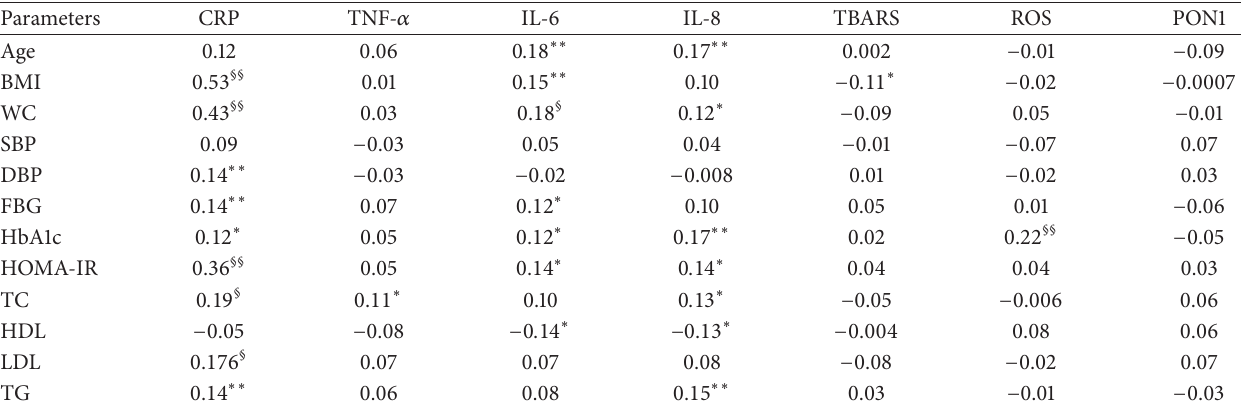
Table 3: Spearman correlation of inflammatory and oxidative stress markers with cardiometabolic risk factors in all study subjects.